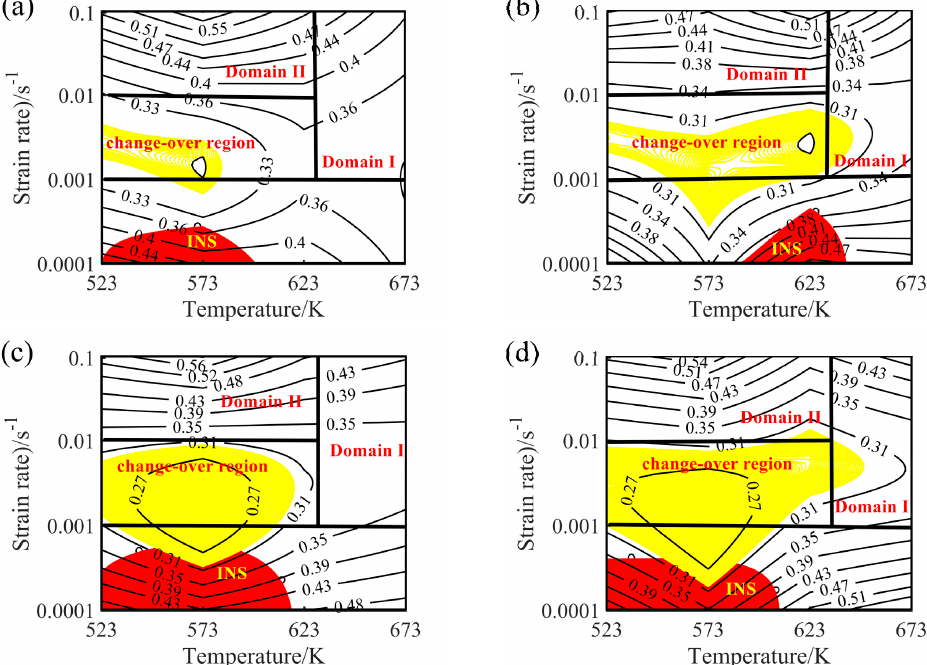
Figure 16. Processing maps for the experimental alloy at different true strains: ( a ) 0.2, ( b ) 0.3, ( c ) 0.4, and ( d ) 0.6. Four different areas can be distinguished, namely a workability region (Domain Ι ), a metastable workability region (Domain ΙΙ ), a transition region (change-over region), and an unsuitable workability region, i.e., instability region (INS). The contour lines in the hot processing map represent the value of energy dissipation efficiency, the yellow area represents the transition region (change-over region), and the red area represents the instability area (INS). The value of power dissipation efficiency greater than 30% is suitable for hot deformation of Mg alloys [43]. Generally speaking, the dissipation efficiency increases with the increase of temperature and the decrease of strain rate. Similarly, the dissipation rate ranges from 0.001 to 0.1 s − 1 , the values of power dissipation efficiency increase with the increase of the strain rates. While the strain rate ranges from 0.0001 to 0.001 s − 1 , the values of power